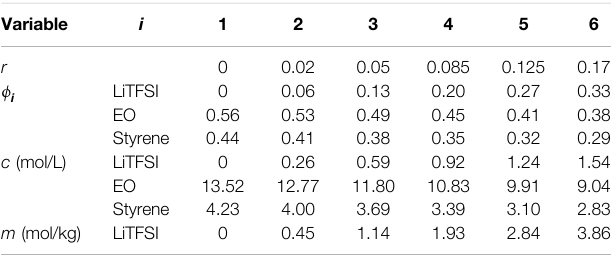
TABLE 1 | Molar ratios ( r ), volume fractions ( ϕ i ), molarity ( c ) and molality ( m ) of SEO/LiTFSI mixtures.